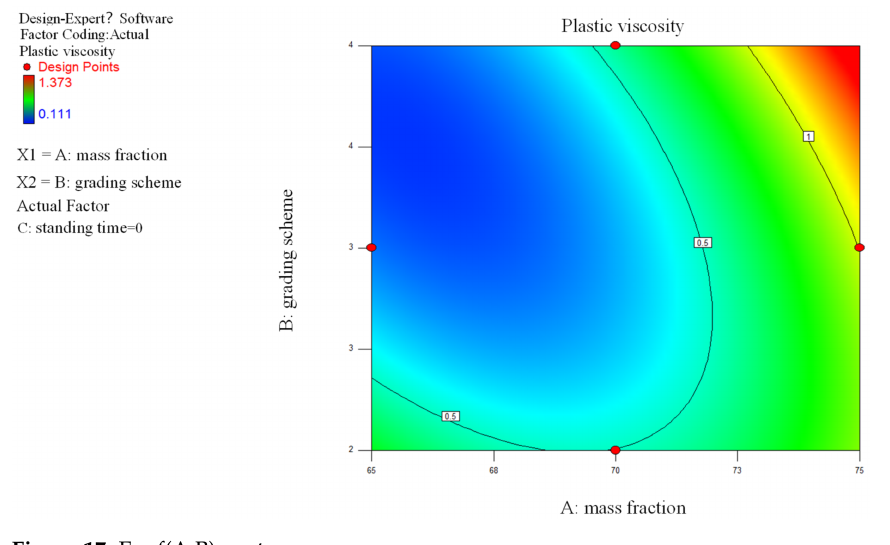
Figure 17. E = f(A,B) contour map.